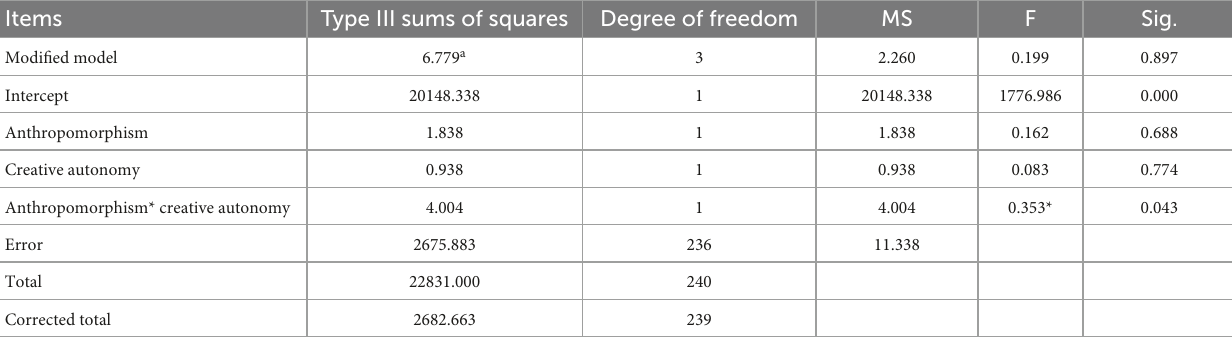
TABLE 3 Test of the effect of anthropomorphism and creative autonomy on the recognition of AI painter’s identity. Items